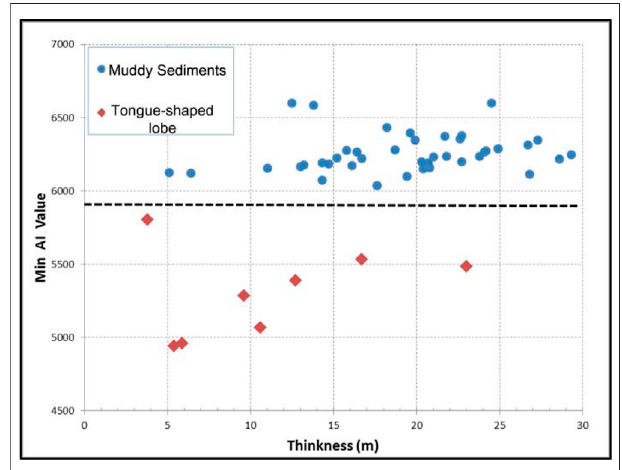
FIGURE 8 | Relationship between thickness and RMS amplitude of different microfacies in AB120